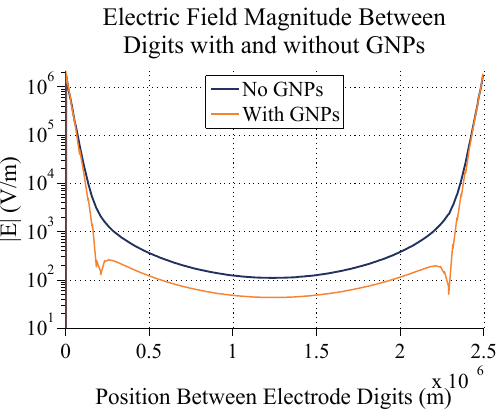
Figure 6. A graph comparing the electric field magnitude between 5 µm digits with 2.5 µm spacing with and without 60 nm gold nanoparticles 20 nm above the